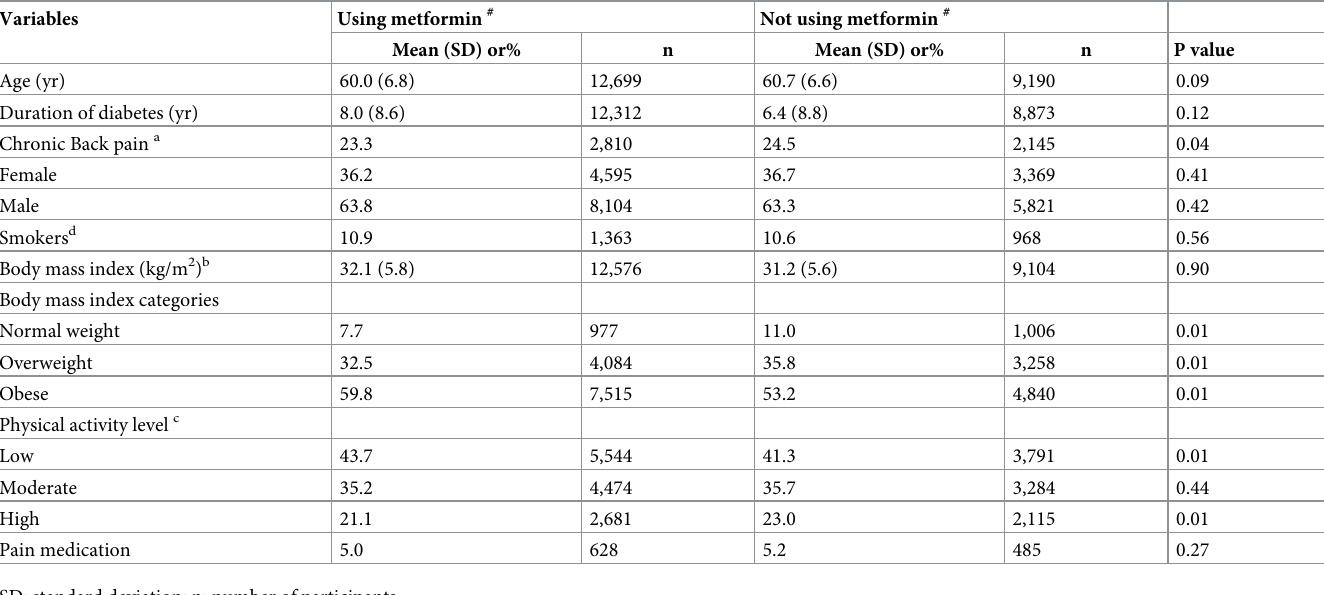
SD: standard deviation; n: number of participants a Prevalence (%) # Percentage within the group b Body mass index classified according to WHO c classification according to short IPAQ scoring. d Smoker, participants who reported being frequent or occasional